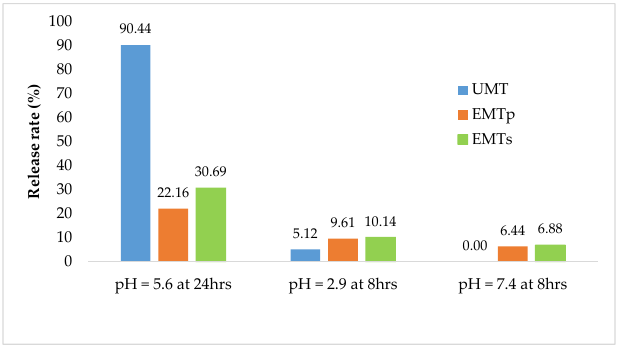
Figure 3. Sequential release rate for UMT, EMT S and EMT P in acetate, citrate and phosphate buff- ers.